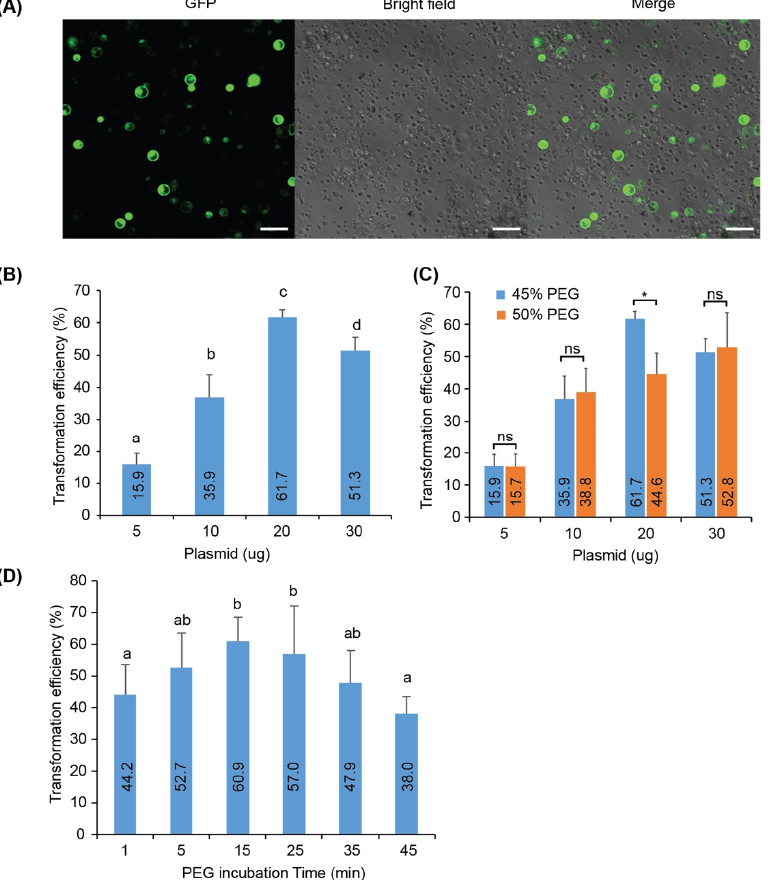
Figure 4. Effect of plasmid amount, PEG concentration, and incubation time on protoplast transfection. ( A ) Visualization of banana protoplasts transiently expressing 35S::GFP under a confocal microscope. Bars = 50 µ m. ( B ) The transformation efficiency (TE) of banana protoplasts transfected with various amounts of plasmid DNA (35S::GFP) using PEG-mediated transfection (using 45% PEG solution). TE was calculated after 12 h cultivation of protoplasts after transformation. * indicates a significant difference to 45% PEG ( p < 0.05 ) in a student’s t -test. ( C ) The effects of PEG concentration on the TE of banana protoplasts transfected with various amounts of plasmid DNA. ( D ) The effects of PEG incubation time on the TE of banana protoplasts. The different letters indicate